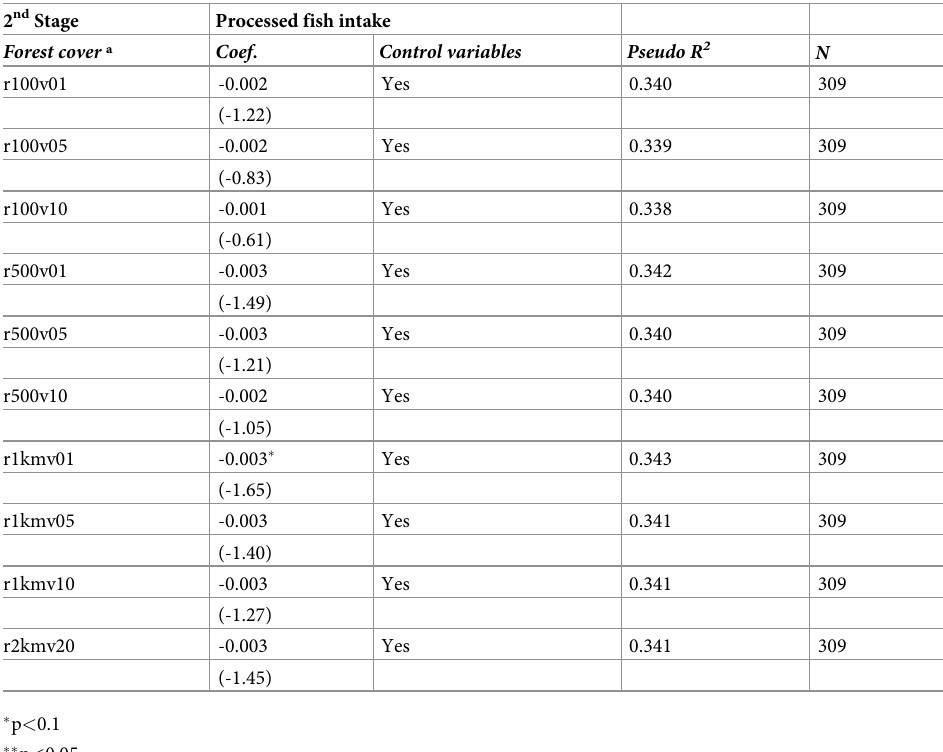
Table 4. Results from the second stage of the double hurdle model for processed fish consumption and forest cover around rivers at the village level across all measures of forest cover (see S6 Table for full results) Z-statistics are given in